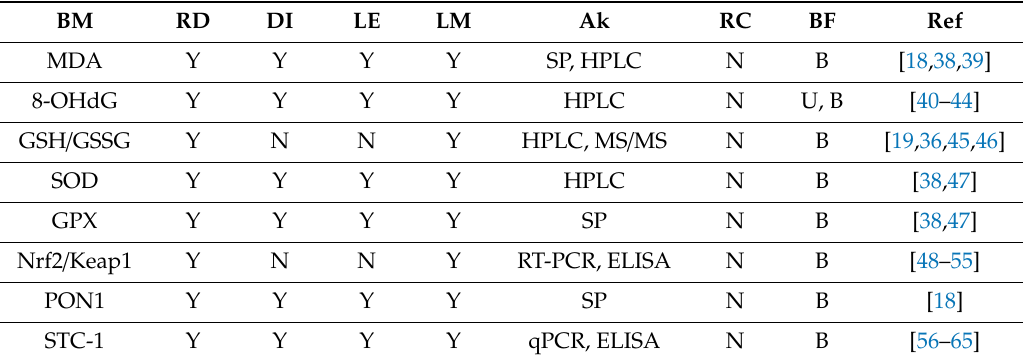
Table 1. Optimality items for a BM according to FDA and EMA